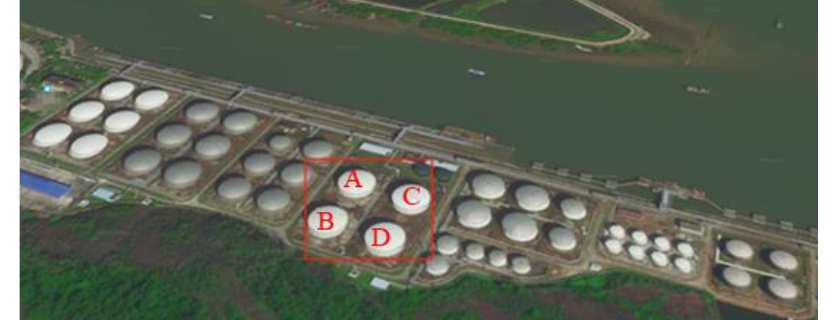
Figure 3. Layout of tank area.